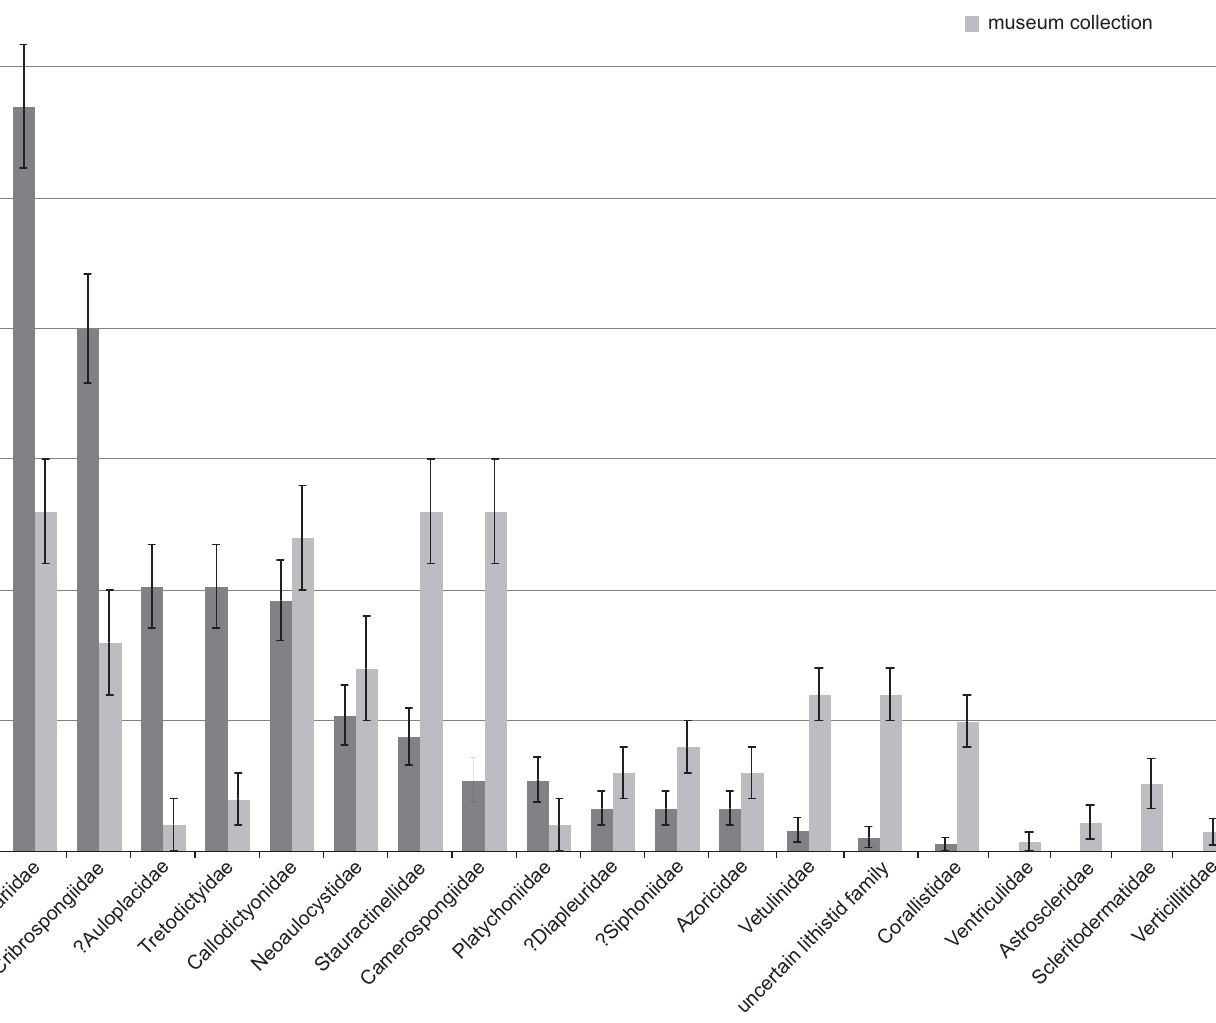
Fig. 7. Families and relative abundances frequencies from museum collections (data from Frisone et al. 2016) and bulk sampling (this study). Error bars denote binomial standard errors of